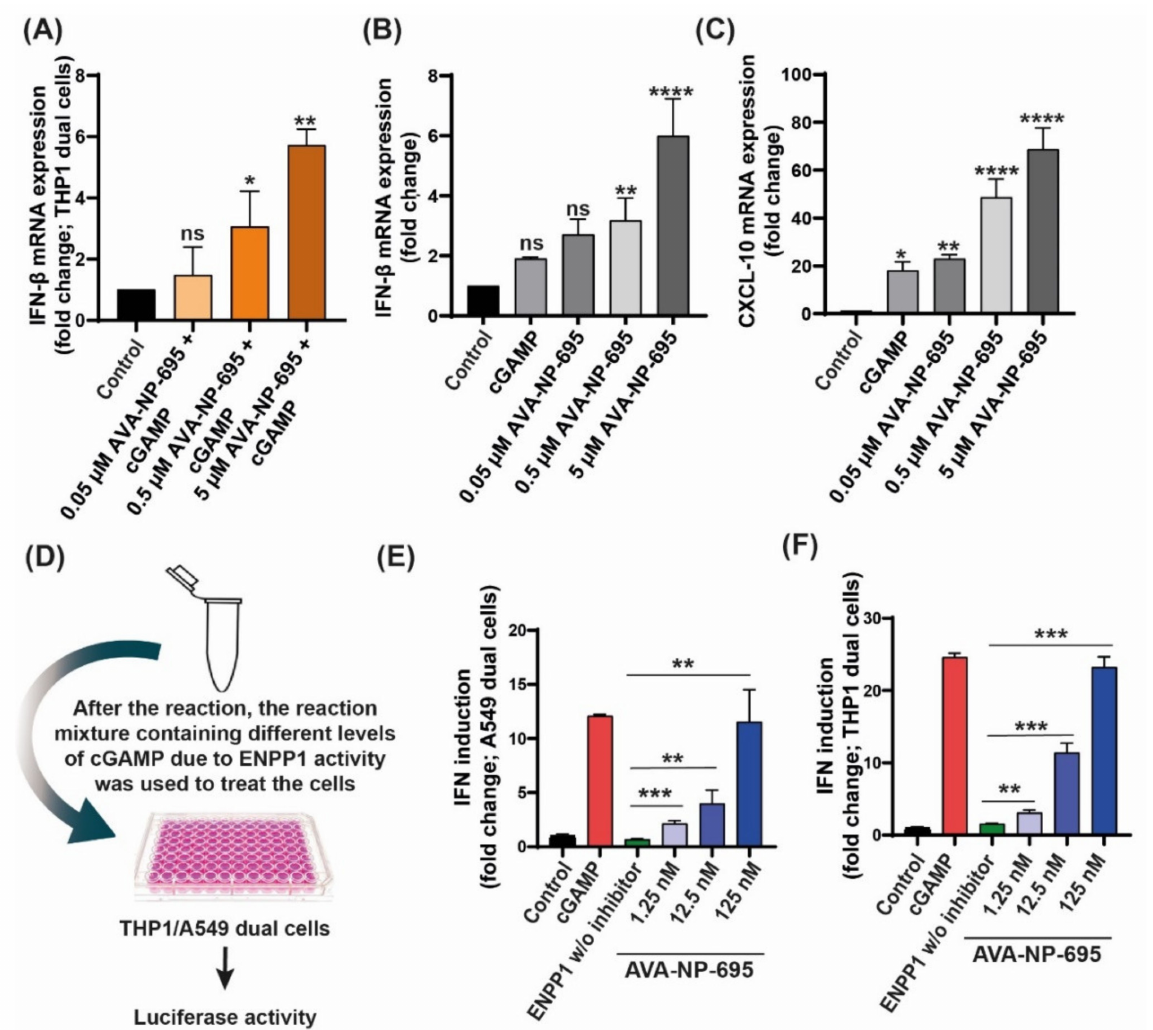
Figure 2. AVA-NP-695 significantly induces IFN response in various in vitro cell studies. ( A ) Effect of AVA-NP-695 on IFN- β mRNA level. THP1 Dual TM cells were treated with different AVA-NP-695 concentrations and 25 µ M of 2 (cid:48) 3 (cid:48) -cGAMP for 24 h and RNA was isolated. IFN- β fold change was plotted; data were normalized using GAPDH . AVA-NP-695 was added 2 h prior to 2 (cid:48) 3 (cid:48) -cGAMP addition (n = 3). ( B , C ) Three million PBMCs were seeded in a 12-well plate. AVA-NP-695 was added to the respective wells at various concentrations. The plate was incubated for 2 h prior to addition of 2 (cid:48) 3 (cid:48) -cGAMP (25 µ M). The plate was further incubated for 24 h. RNA was isolated after the incubation, followed by RT-PCR for IFN- β ( B ) and CXCL-10 ( C ) mRNA quantification. GAPDH was used as endogenous control (n = 2). ( D ) Schematic representation of functional effect of ENPP1 inhibition on IFN induction in ( E ) A549 Dual TM and ( F ) THP1 Dual TM cells. After the in vitro enzymatic reaction, 10 µ L of the reaction mixture was diluted by adding 120 µ L of complete RPMI. This diluted mix was used to treat the cells for 24 h. IFN induction was estimated by a luciferase reporter assay under the control of IFN-stimulated response elements. For all the experiments, control groups were considered to be 1 and the p -values were calculated with respect to the control group using ordinary one-way analysis of variance followed by Dunnett’s test. For comparison between two internal groups, Dunnett’s multiple comparison test was performed. * p < 0.05, ** p < 0.01, *** p < 0.001, **** p < 0.0001, ns: